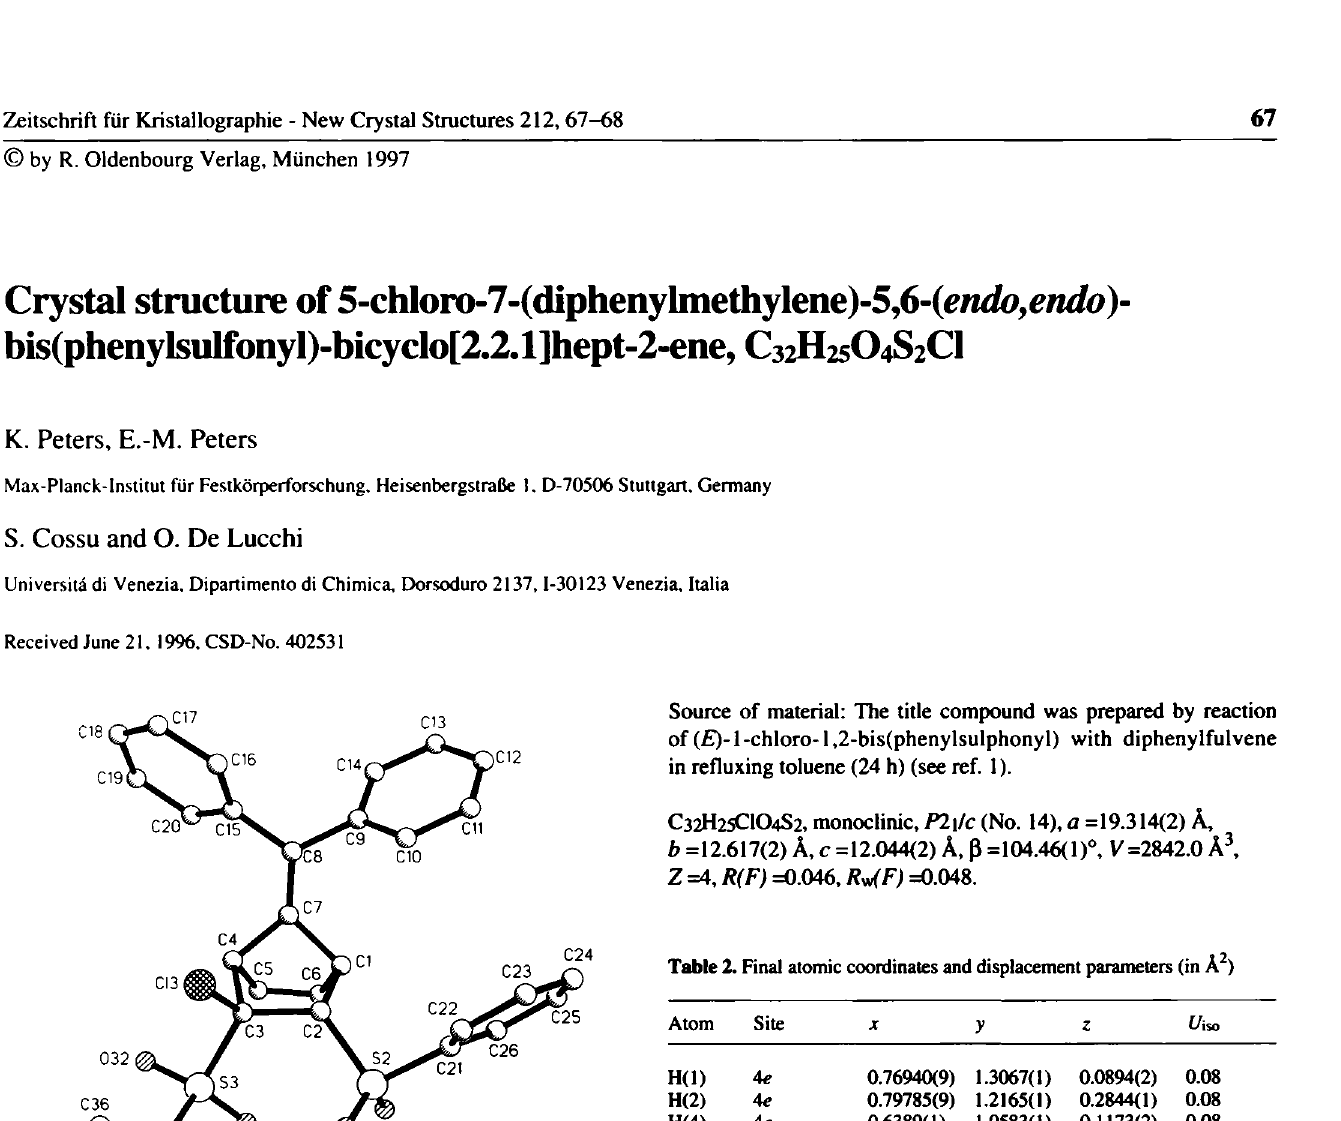
Table 2. Final atomic coordinates and displacement parameters (in A 2 )